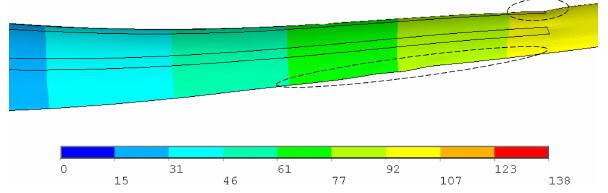
Figure 16. Total deformation occurring in the form of local de- formation due to failed elements at 105% flapwise (max) loading. (Scale factor for deformation plot: ×